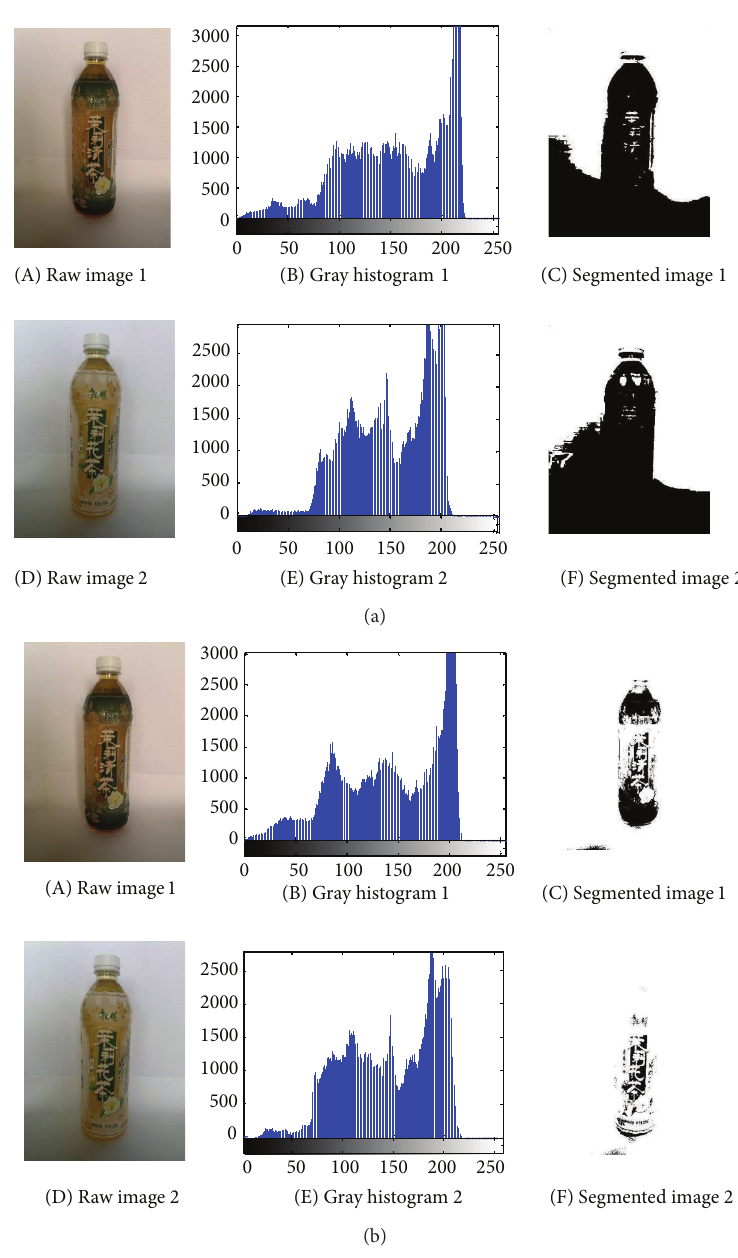
Figure 2: (a) Otsu segmentation on images in group 1. (b) 2DMETS on images in group